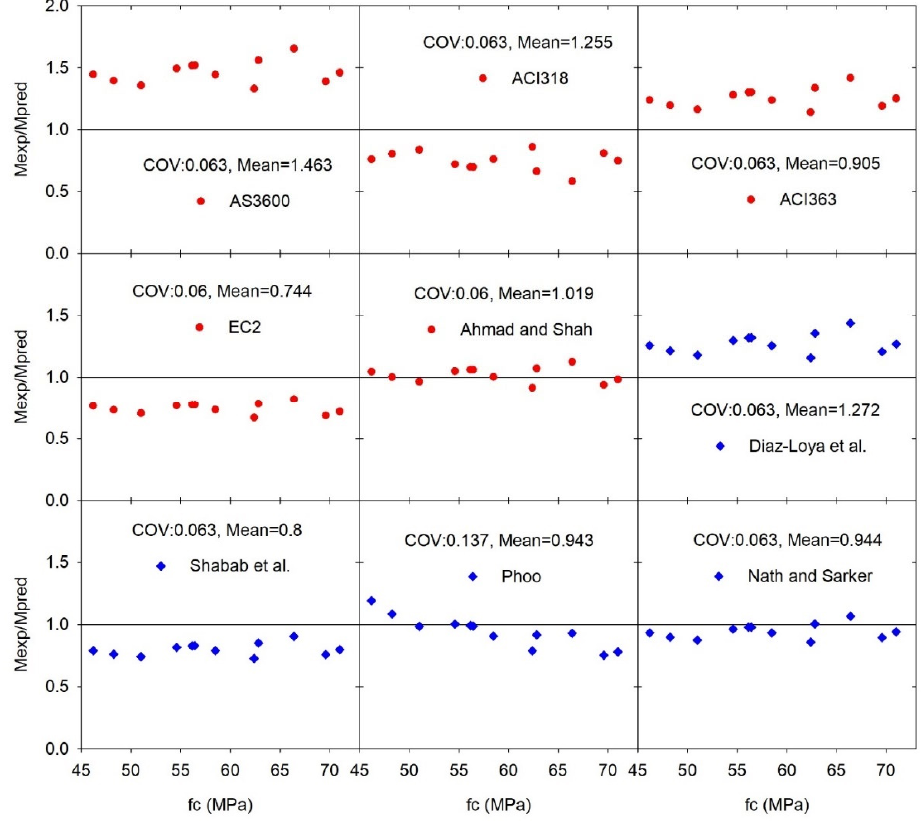
Figure 8. Scattering of M cr,Exp./ M cr,pred values. Table 5. Comparison of nominal moment